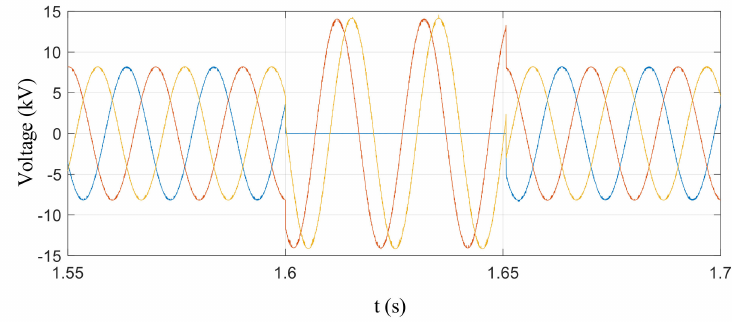
Figure 8. Voltage waveform of the ground of the 10 kV AC